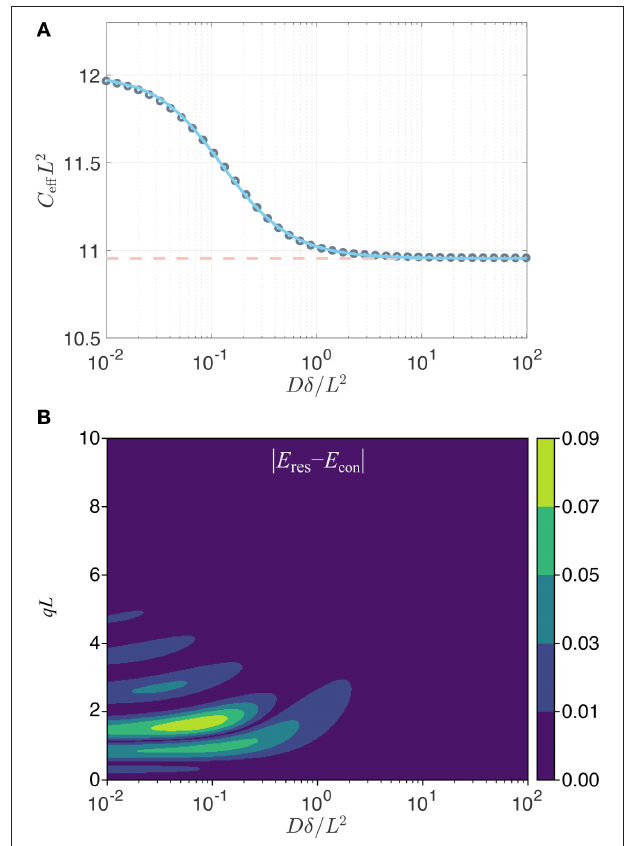
FIGURE 1 | (A) Effective dimensionless confinement value (gray circles) computed by matching the variances of the center of mass distributions in the two problems plotted vs. the dimensionless time D δ/ L 2 . The variation in C eff L 2 value is well-captured (error less than 0.12%) by the expression √ 120)( α x ) k γ [1 y 12 (12 ( α x ) k ] − γ , with α 9.495, γ 1.210, and = − − + = = k 1.266 (blue line). The dashed line indicates the asymptotic value √ 120. = (B) The absolute value of the difference in the normalized signals implied by the two problems (restricted diffusion with separation L , and the Hookean √ 120 L − 2 ) for a traditional potential with a confinement value taken to be C = Stejskal-Tanner sequence [ 32] with two gradient pulses whose leading edges are separated by 1 with D 1/ L 2 100. The restricted diffusion signal was = computed using the multiple correlation function method [33,